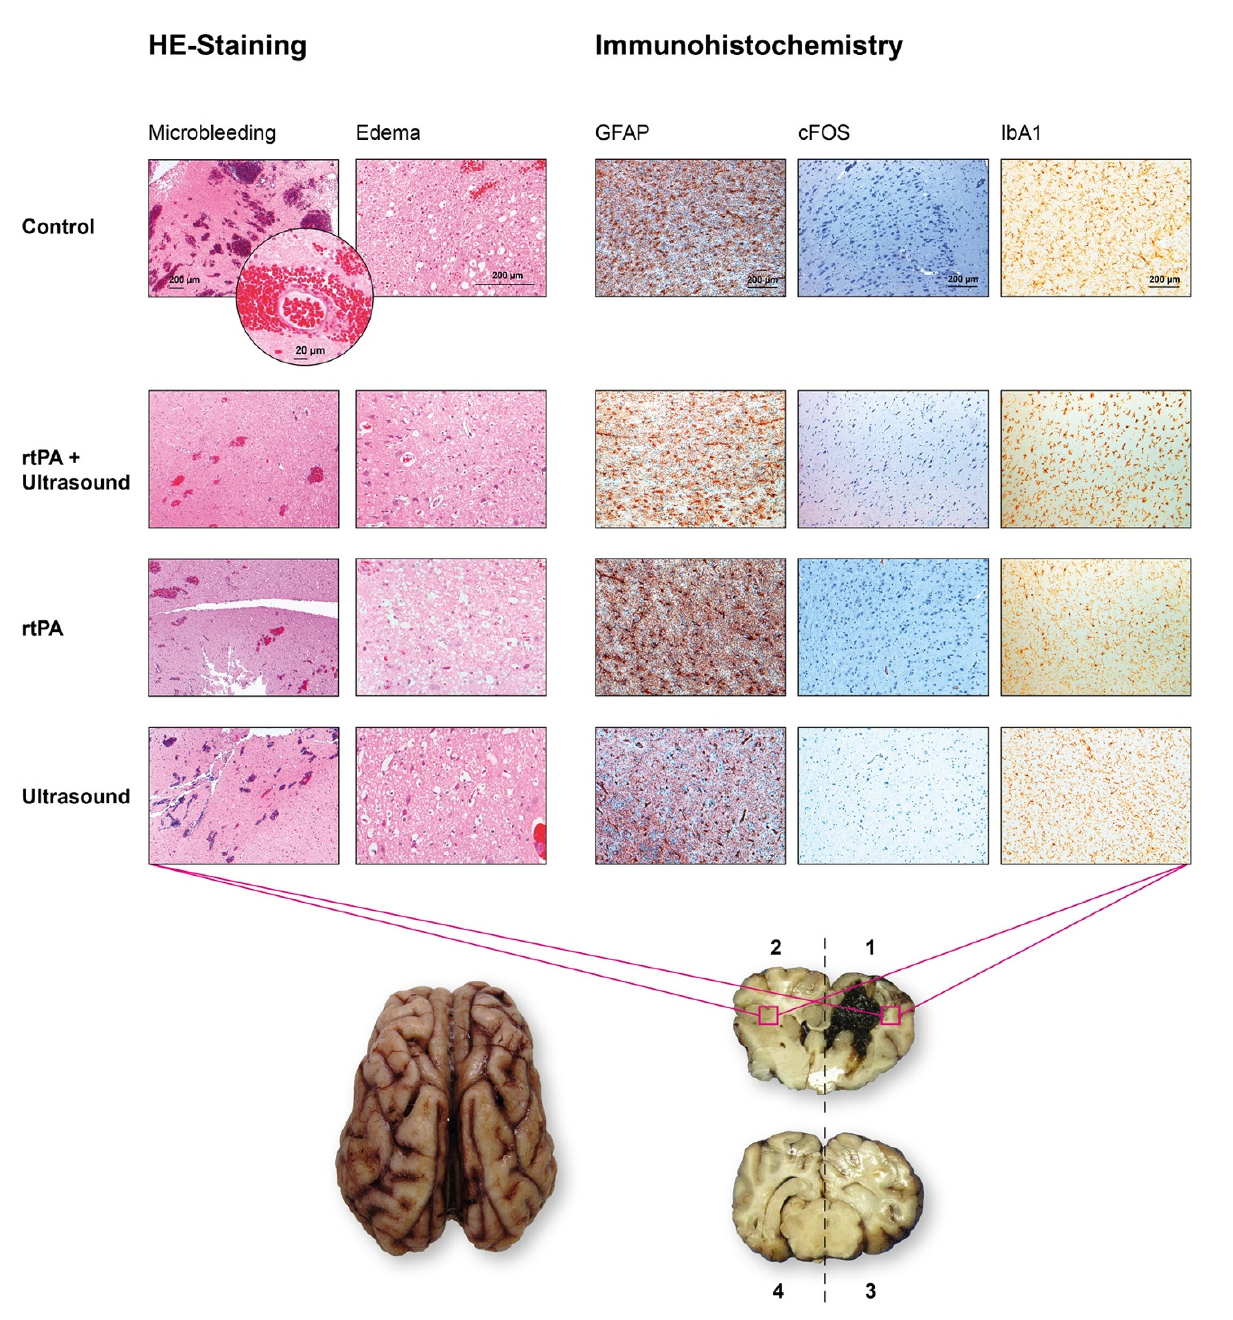
Figure 6. HE-staining and Immunohistochemistry. On the left side, there are representative HE-staining images. On the right side, representative immunohistochemistry images without significant differences are shown. All images were chosen from the brain area 1 (perihematomal, right frontal) and area 2 (left frontal, contralaterally), which are marked as red quadrats in the brain slice below the panels. The bar in each image represents 200 µ m, except the round magnification of the first picture. Here, the bar represents 20 µ m showing a typical perivascular microhemorrhage. Panel 1, row 1 shows microhemorrhages (3 points) and edema (2 points) using HE-staining, which is representative for area 1 of the control Group (Figure 5b). The HE-stain images of the other groups show a similar occurrence of microhemorrhages (each 2 points) and edema (each 2 points). Table 1. Score of immunohistochemistry perihematomal (area 1) and contralaterally (area 2) to the ICH (control Group n = 3; treatment groups (2–4); each n = 6).